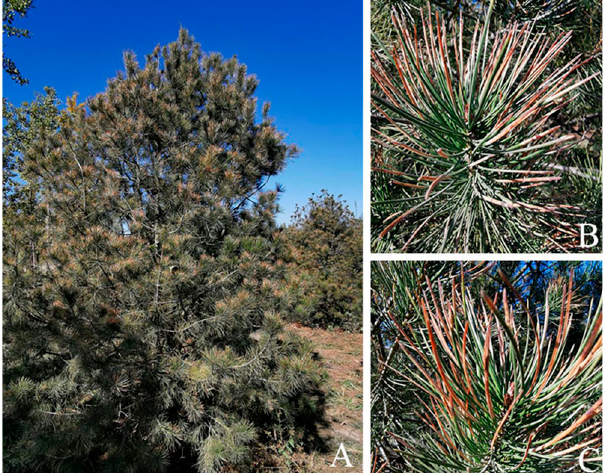
Figure 1. Symptoms of infection by A. alternata on P. bungeana in the field. ( A ), Withered tips of the whole tree. ( B , C ), Magnified image showing symptoms on needles.